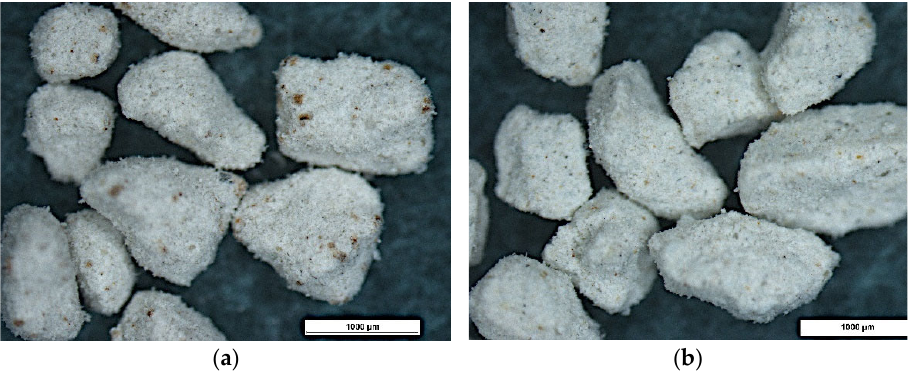
Figure 10. Microscope pictures of A ‐ 1 agglomerate ( a ) and A ‐ 2 agglomerate ( b ).